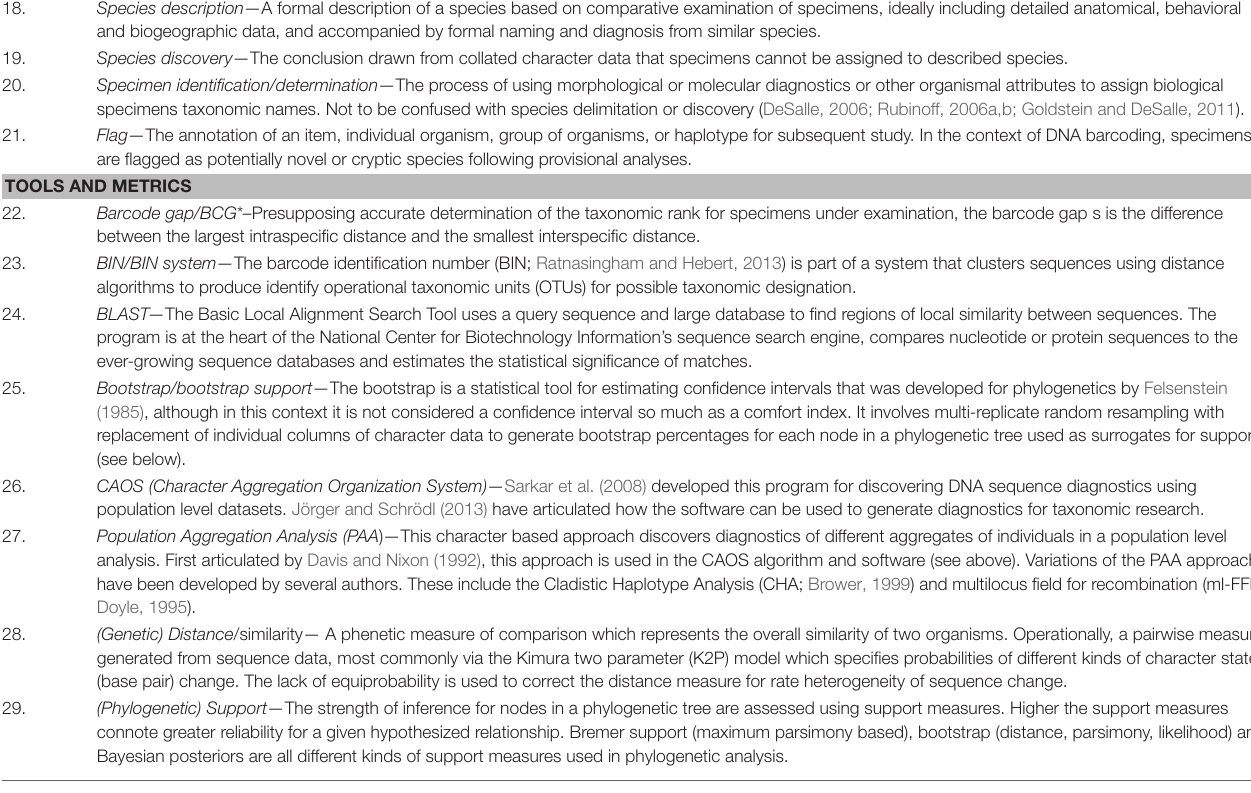
TABLE 2 | A (not-exhaustive) categorization of the analysis space for DNA barcoding.